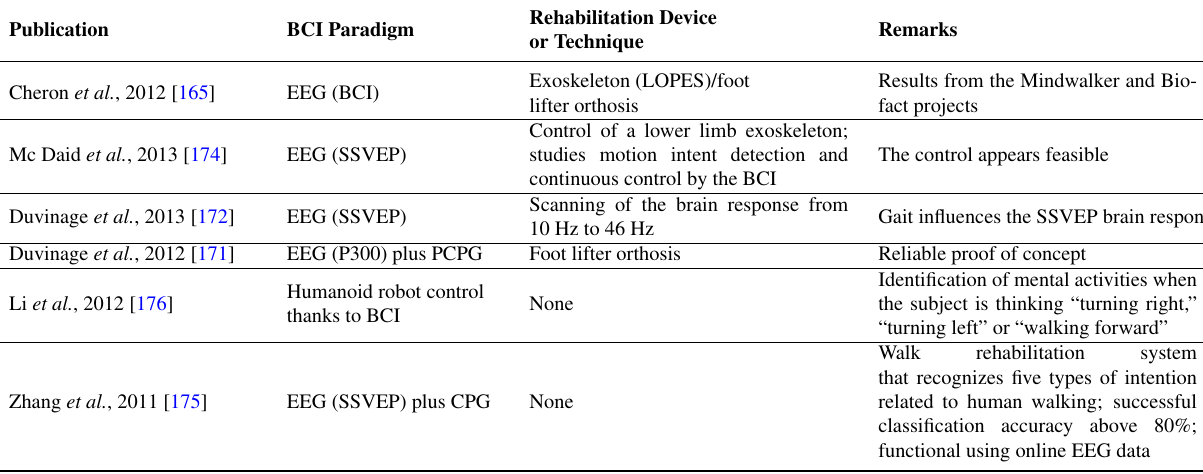
A few applications. SSVEP, steady-state visually evoked potential; PCPG, programmable central pattern